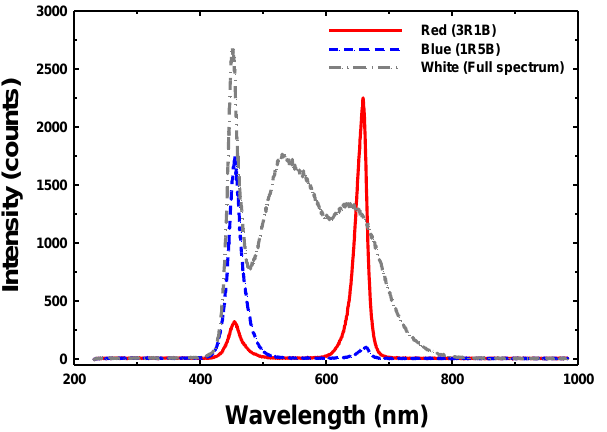
Figure 5. Light spectra of the red (3R1B), blue (1R5B) and white (Full spectrum) lighting at plant